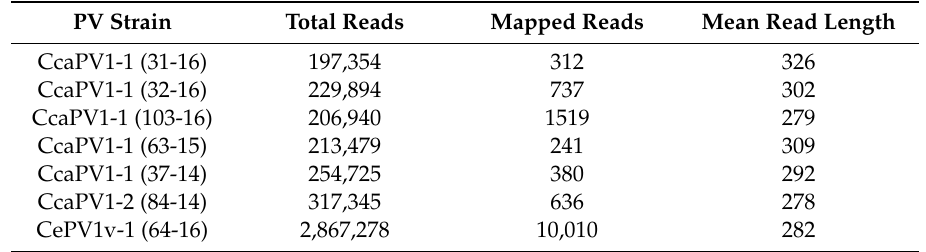
Table 2. Results of the whole-genome sequencing of the PV genomes and the assembly